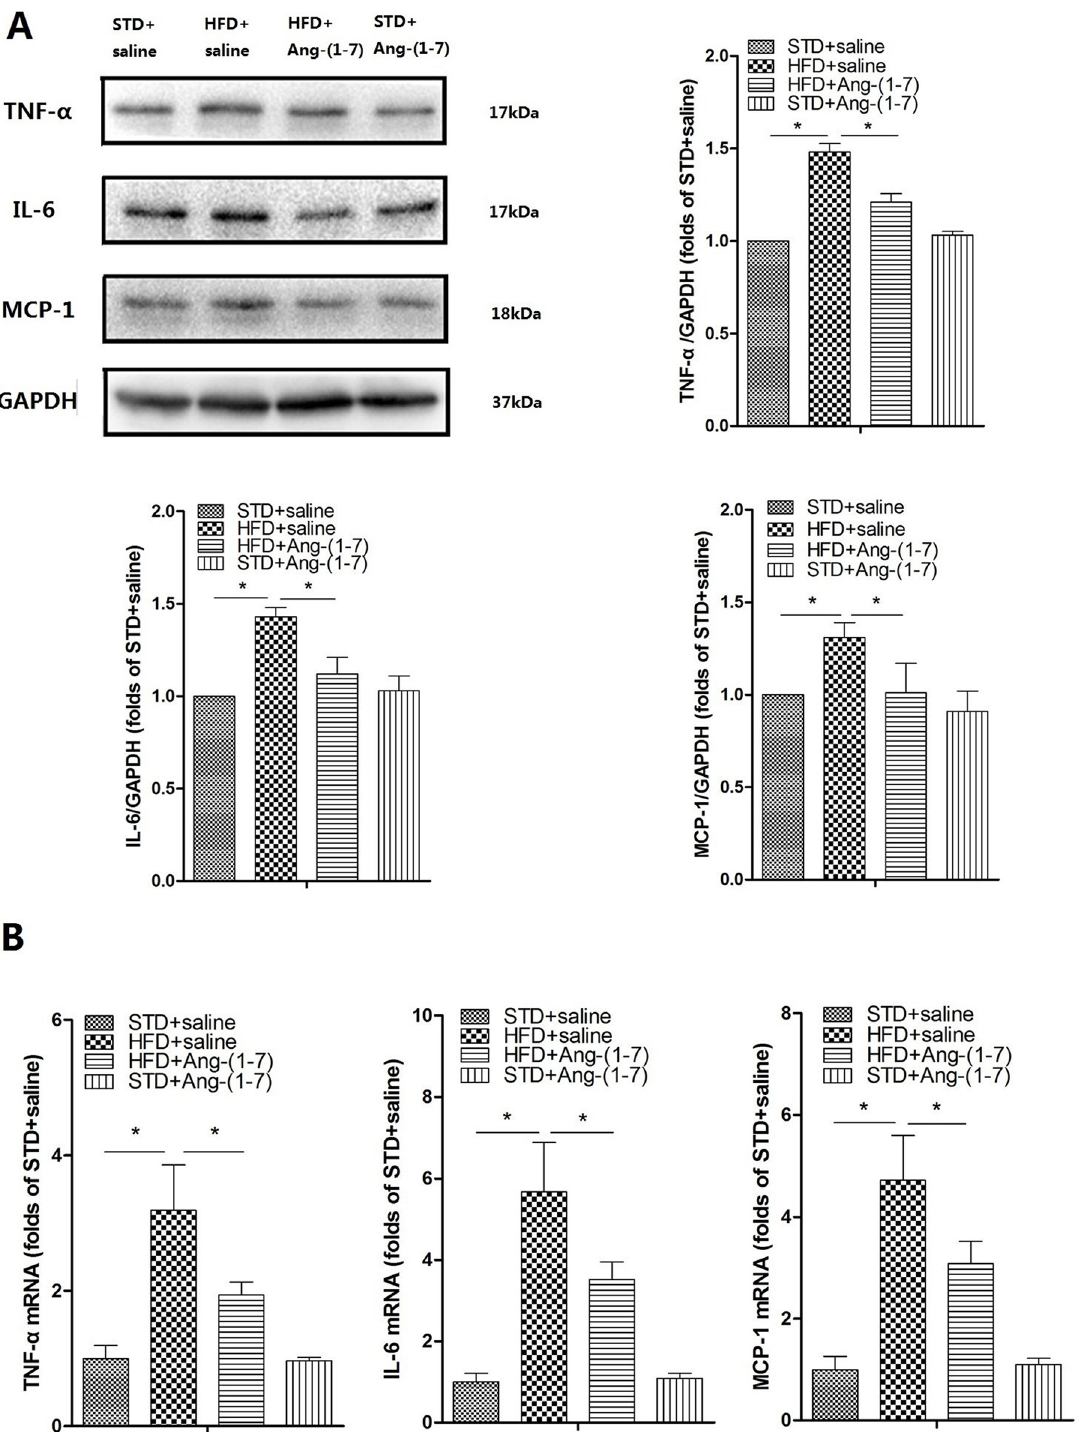
Fig 2. Ang-(1 – 7) mitigates HFD-induced high inflammation status in kidney. A: Representative immunoblots for TNF- α , IL-6 and MCP-1. Representative quantitative analysis of TNF- α , IL-6, and MCP-1. Values are expressed as means ± SD (n = 6). B: TNF- α , IL-6 and MCP-1 mRNA levels were measured using real-time PCR. The GAPDH gene served as the internal control. Values are expressed as means ± SD (n = 6), * P < 0.05.